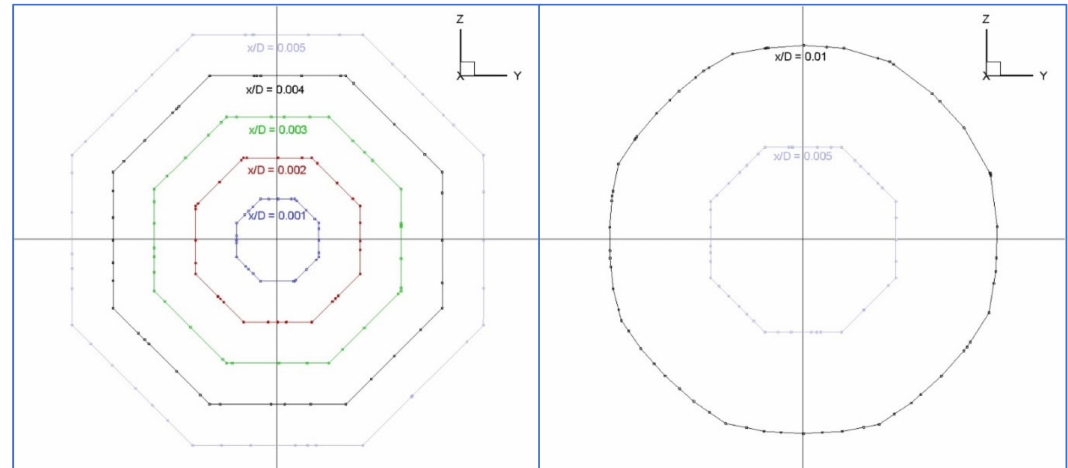
Figure 4. ( Left ) surface mesh cross sections at x/D = 0.001 to x/D = 0.005. ( Right ) surface mesh cross sections at x/D = 0.005 to x/D = 0.010. Reference unstructured grid (Grid U1).